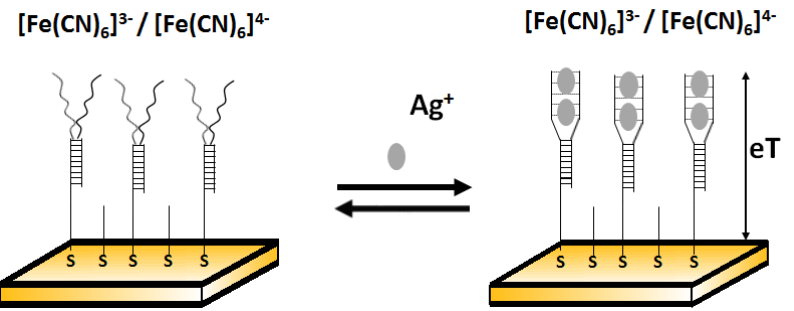
Figure 14. Electrochemical biosensor fabrication with Y-shaped dsDNA in the receptor layer before ( left ) and after ( right ) adding silver ions.